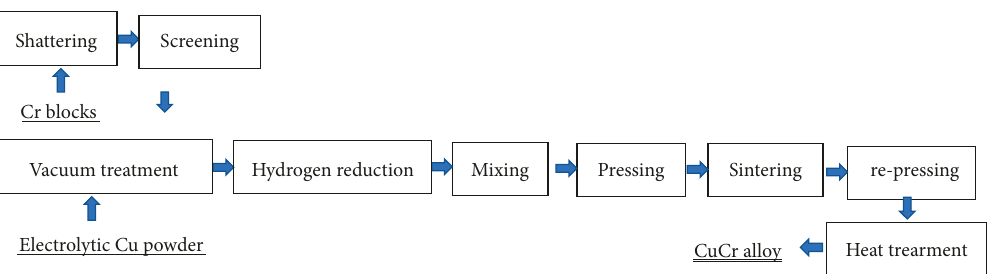
Figure 5: Process flow of CuCr alloy preparation by powder sintering [15].